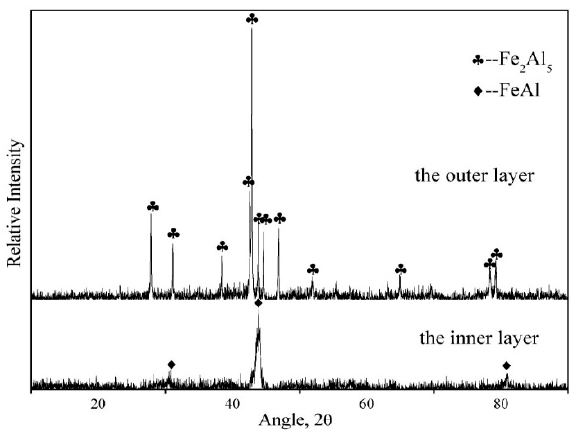
Figure 6. X-ray diffraction patterns of pack aluminizing spheroidal graphite cast iron. Figure 6. X-ray di ff raction patterns of pack aluminizing spheroidal graphite cast